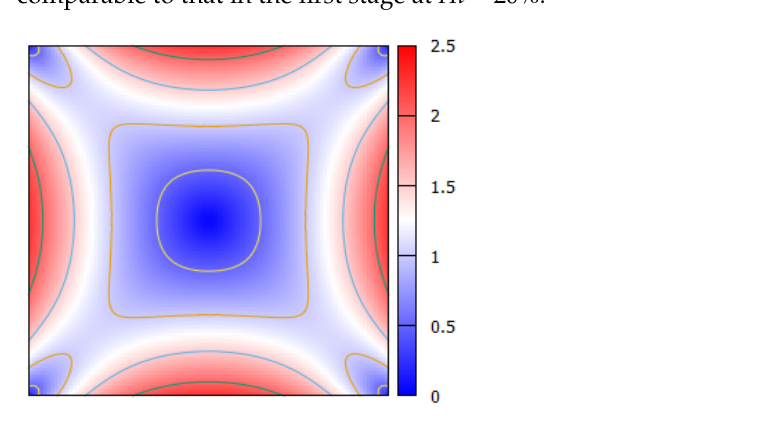
Figure 8. Contours of the normalized shear rate, |𝛾(cid:4662)|/( square channel.